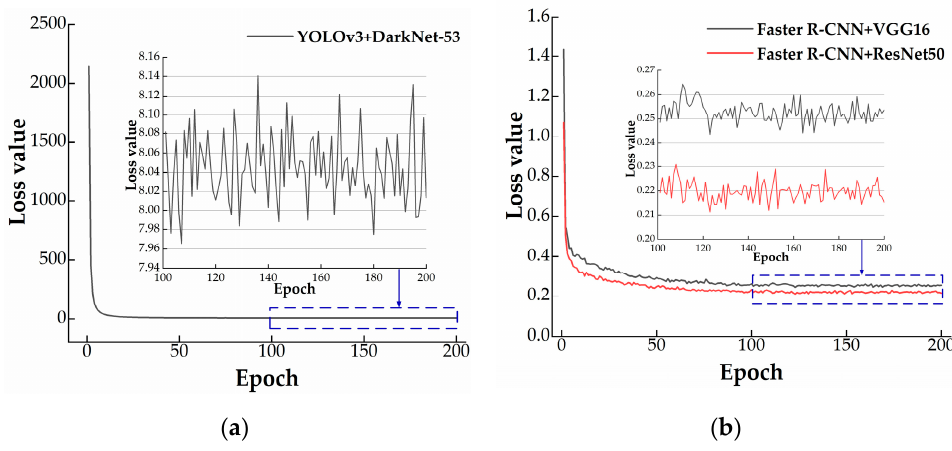
Figure 10. Comparison of loss values and training algebra curves: ( a ) YOLOv3 + DarkNet-53 algorithm comparison chart; ( b ) Faster R-CNN + VGG16 and Faster R-CNN + ResNet50. algorithm comparison chart; ( b ) Faster R-CNN + VGG16 and Faster R-CNN +